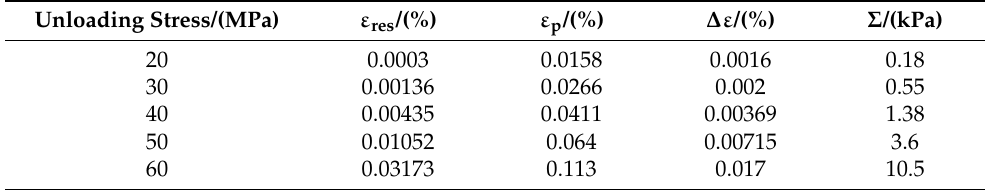
Table 3. Cyclic loading/unloading damage parameters of Type 1 3D needle-punched C/SiC